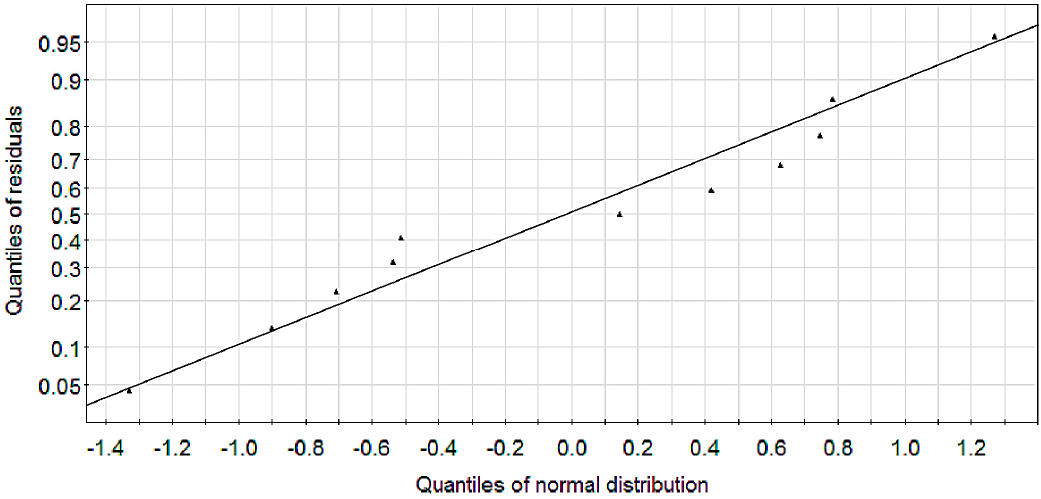
Figure 10. PLS-QSAR residual scatter.